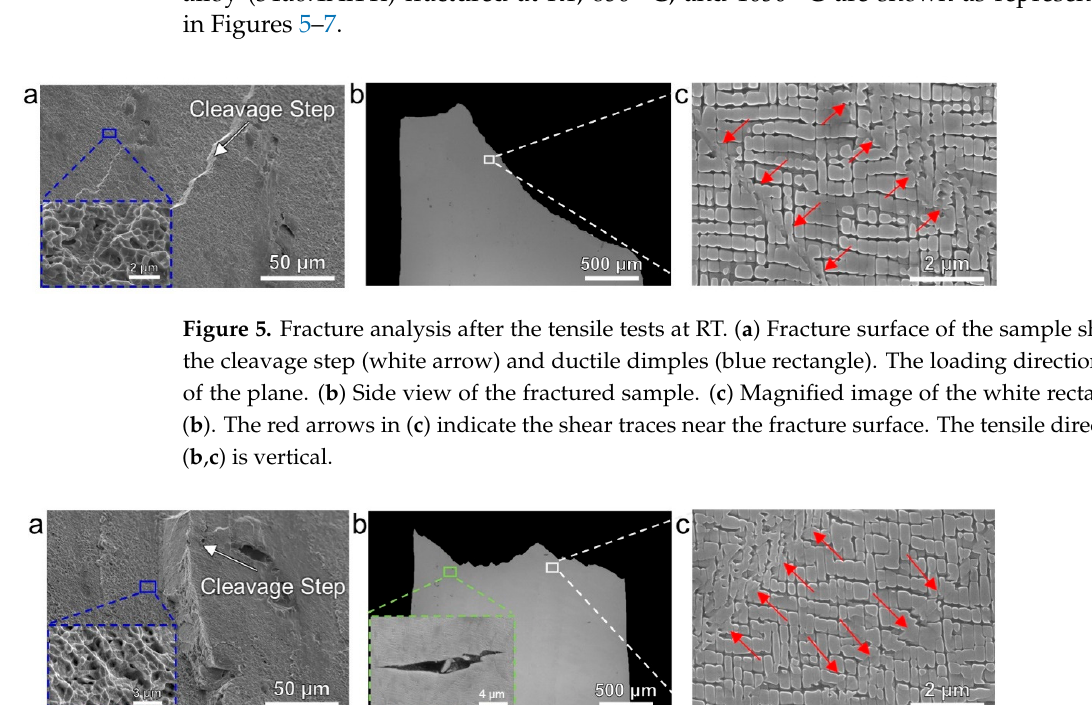
Figure 6. Fracture analysis after the tensile tests at 850 °C. ( a ) Fracture surface of the sample showing the cleavage step (white arrow) and ductile dimples (blue rectangle). The loading direction is out of plane. ( b ) Side view of the fractured sample showing the microvoids (green rectangle) in the interdendritic region. ( c ) Magnified image of the white rectangle in ( b ). The red arrows in ( c ) indicate shear traces near the fracture surface. The tensile direction in ( b , c ) is vertical.